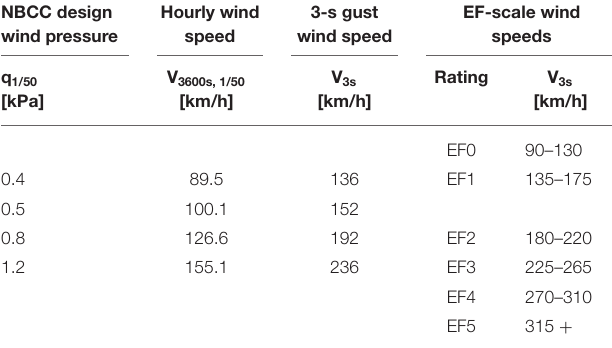
TABLE 2 | Comparison of NBCC (Canadian Commission on Building and Fire Codes, 2015) design wind pressures with 3-s gust wind speeds as implemented in the EF-Scale ( Environment Canada,